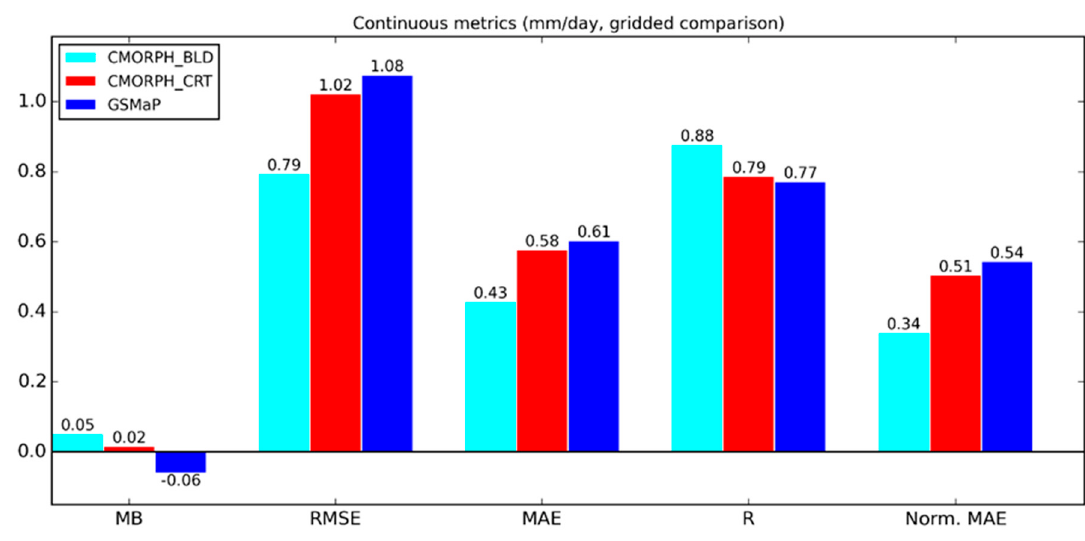
Figure 2. Gridded continuous comparison of satellite datasets against Australian Water Availability Project (AWAP) from January 2001 to December 2018. Mean bias (MB), root-mean-square error (RMSE), mean average error (MAE), Pearson’s correlation coefficient (R) and normalised mean average error (Norm. MAE) are displayed.